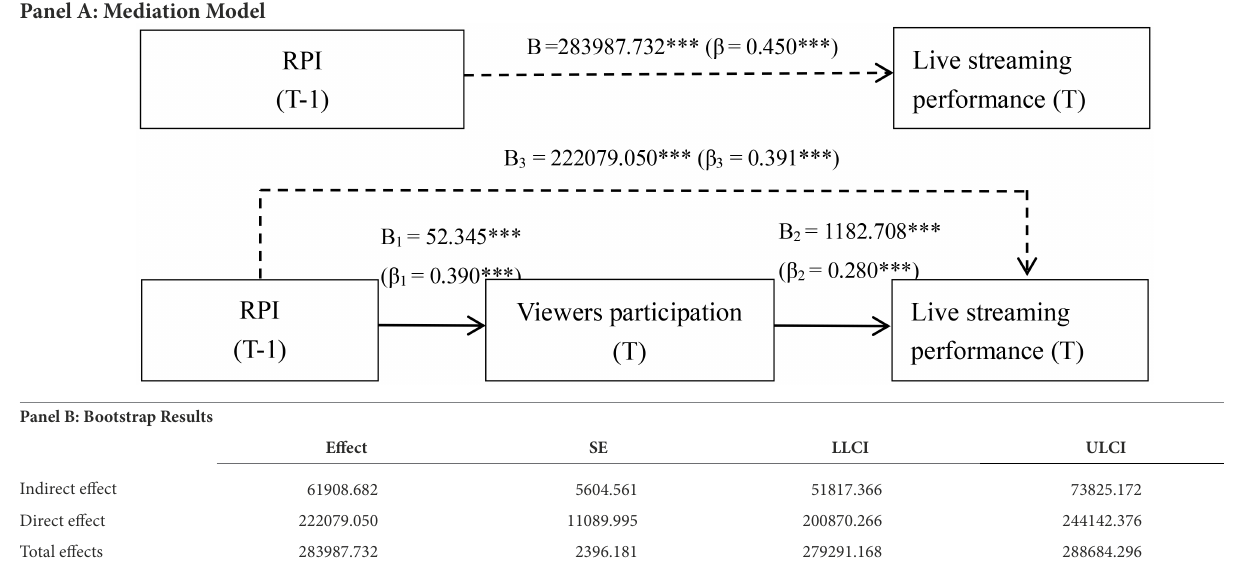
TABLE 3 Mediating effect of viewer